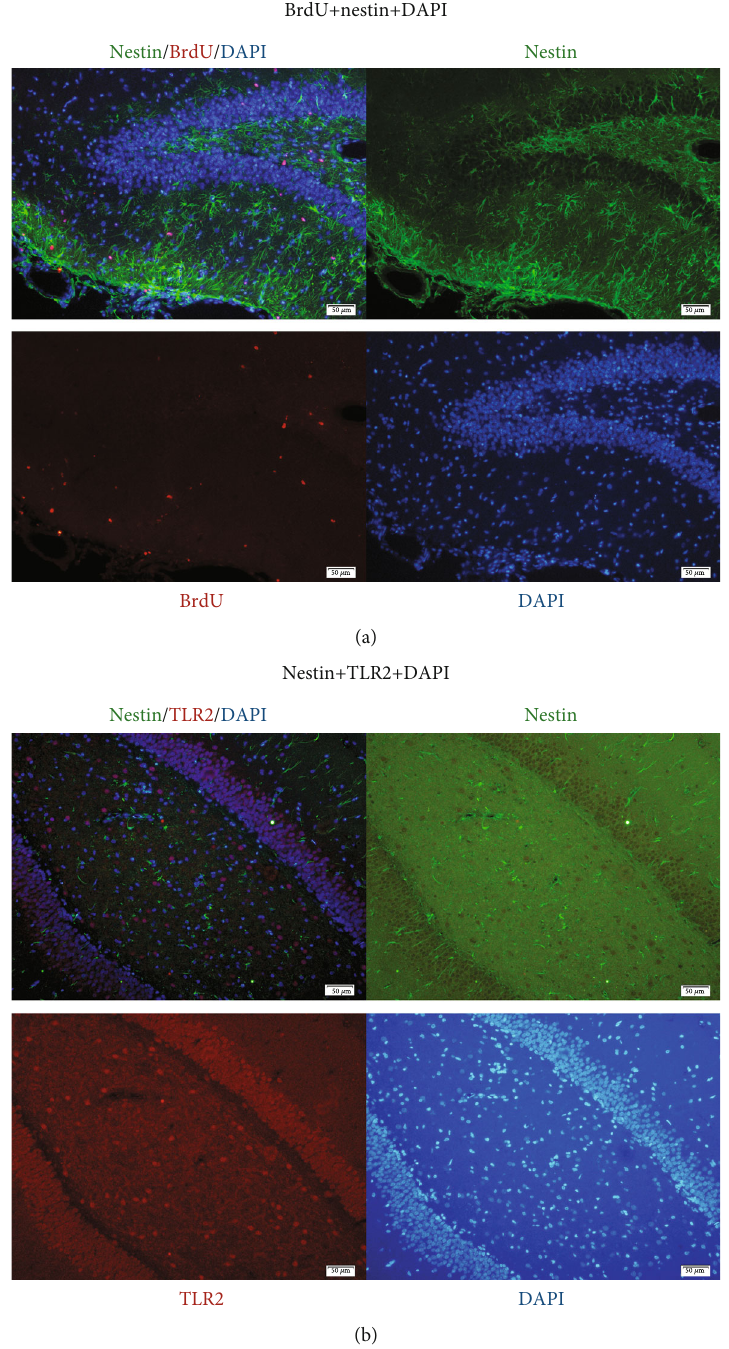
Figure 3: IF in the DG of the TBI group (mouse brain got from 3 days posttrauma). (a) BrdU (red), nestin (green), and DAPI (blue), respectively, exhibited proliferating cells, NSCs, and cell nuclei in the DG. Merged pictures of BrdU + /nestin + /DAPI + showed NSCs (the percentage of NSCs in proliferating cells was 84 : 30 % ± 6 : 54 % ); scale bar: 50 μ m; data were expressed as mean ± SEM . (b) Nestin (green), TLR2 (red), and DAPI (blue), respectively, exhibited NSCs, TLR2 expression, and cell nuclei in the DG. Merged pictures of nestin + /TLR2 + /DAPI + showed the expression of TLR2 on NSCs. Scale bar: 50 μ m; data were expressed as mean ± SEM